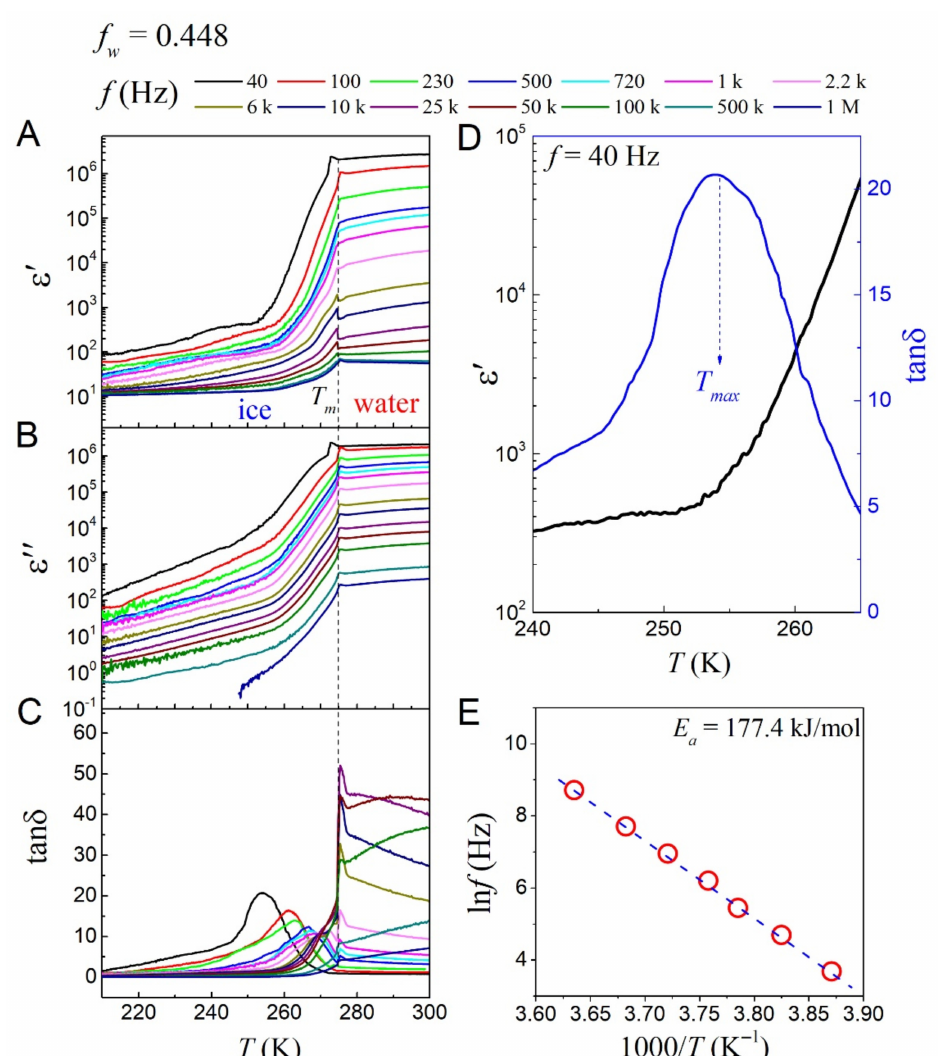
Figure 5. ( A – C ) Measured the real part of permittivity ε ’, imaginary part of permittivity ε ”, and loss tan δ as a function of temperature T at several frequencies, respectively, which are the hydrogels ( f w = 0.448) data measured from the heating program starting at 200 K. For more clarity, the measured ε ’( T ) and tan δ ( T ) data at f = 40 Hz are shown in ( D ). ( E ) Calculated the activation energy E a by the Arrhenius equation and evaluated the relationship between T max and f